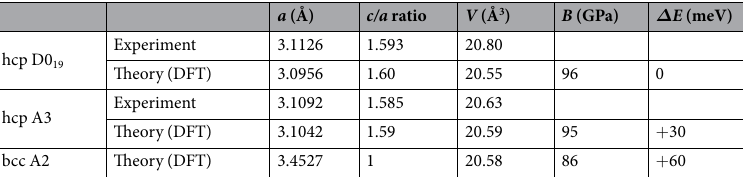
Table 2. Measured and theoretically predicted values for the lattice parameter a , c/a -ratio, and volume per atom V for the Al 15 Hf 25 Sc 10 Ti 25 Zr 25 at.% HEA. The experiments have been performed at ambient temperature whereas the theoretical DFT values correspond to 0 K. Additionally, the theoretical 0 K values for the bulk modulus B and the energy difference Δ E with respect to the D0 19 phase are